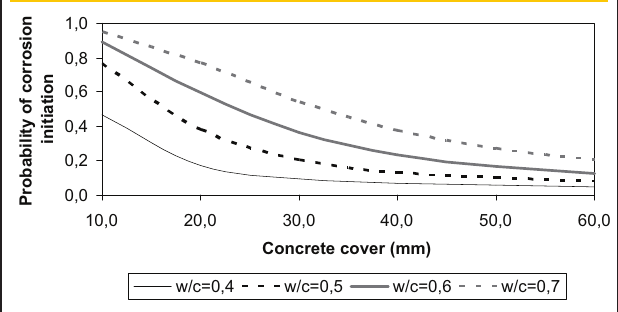
Figure 10 – Evolution for probability of corrosion initiation – C.A.III structural life-time = 5 years